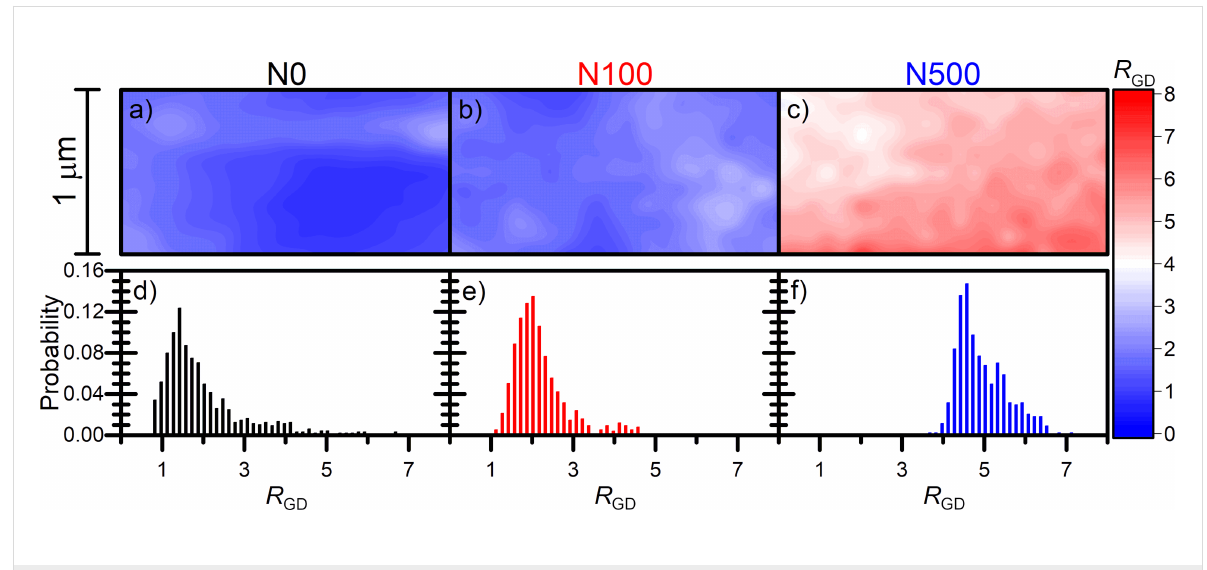
Figure 6: 2D maps (a–c) and histograms (d–f) of the intensity ratio of the G and D bands ( R GD ) for all the three samples analysed.